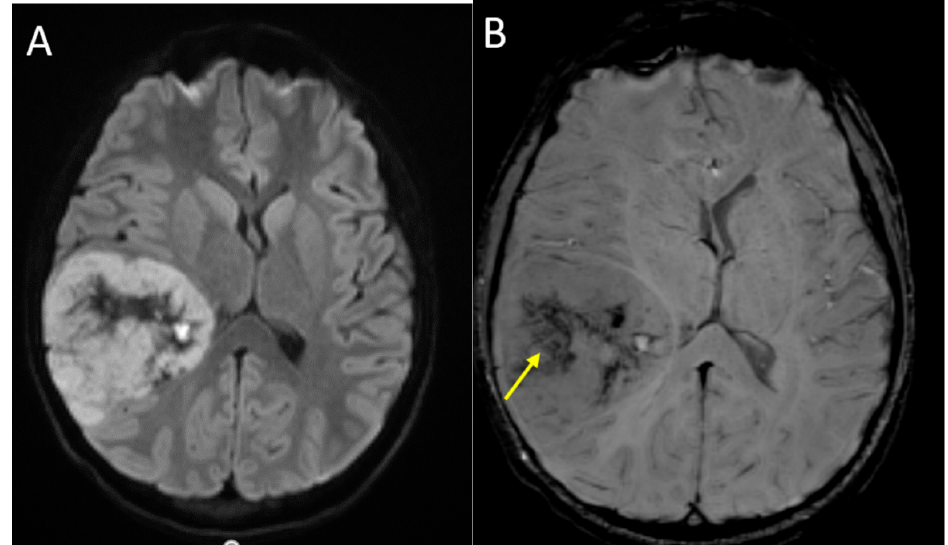
Figure 6. A 5-year-old boy with diffuse midline glioma H3K27-altered. Axial T2 ( A ), post-contrast T1 ( B ) images demonstrate a poorly marginated infiltrative, expansile T2 hyperintense lesion centered in the pons with little to no enhancement. DWI ( C ) and ADC ( D ) images demonstrate heterogenous signal without significant diffusion restriction.